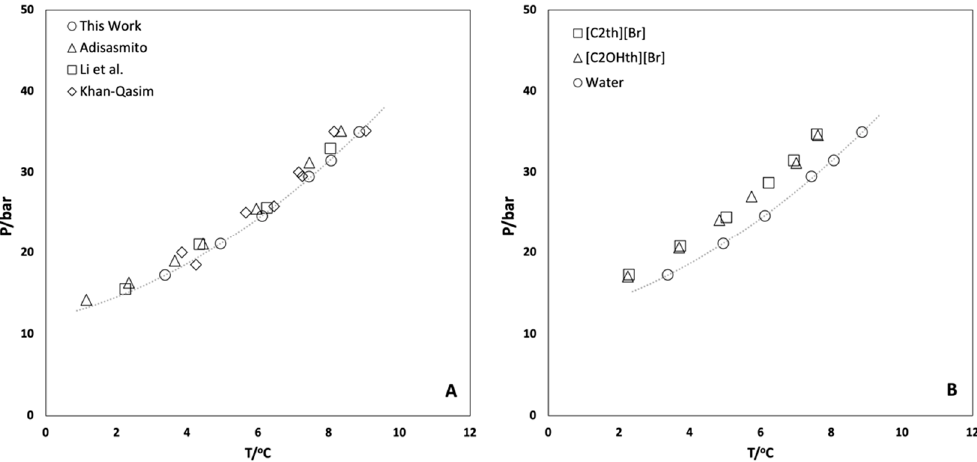
Figure 3. ( A ) CO 2 hydrate vapor liquid equilibrium (HLVE) conditions in Milli ‐ Q water obtained in this work along with the values reported in the literature for comparison [50–53] and ( B ) the values obtained in the presence of 10 wt% aqueous solutions of ionic liquids. The dashed lines are just a guide to the eye.